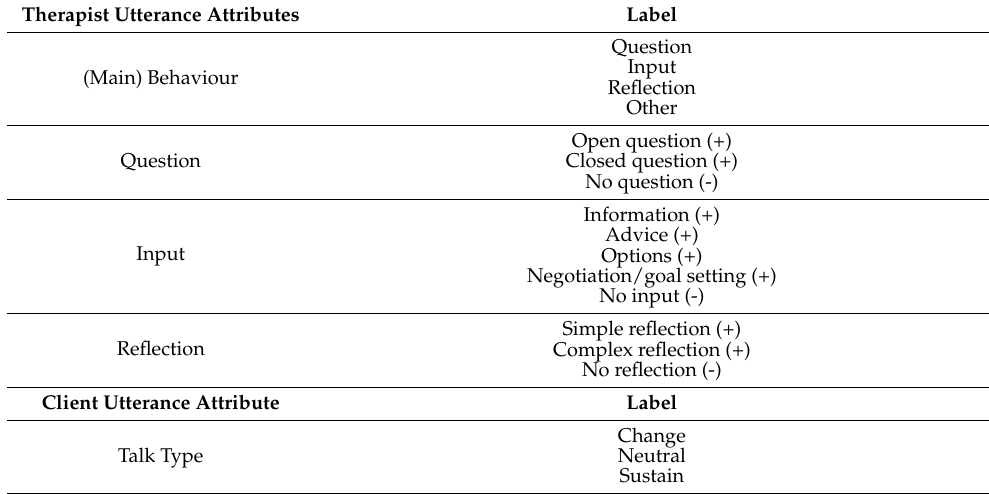
Table 4. Utterance-level multi-choice annotation scheme. (+) implies presence of utterance attribute (e.g., “Simple reflection“ entails that Reflection exists in utterance), while (-) indicates absence thereof (e.g., “No reflection” label implies that Reflection is not present in